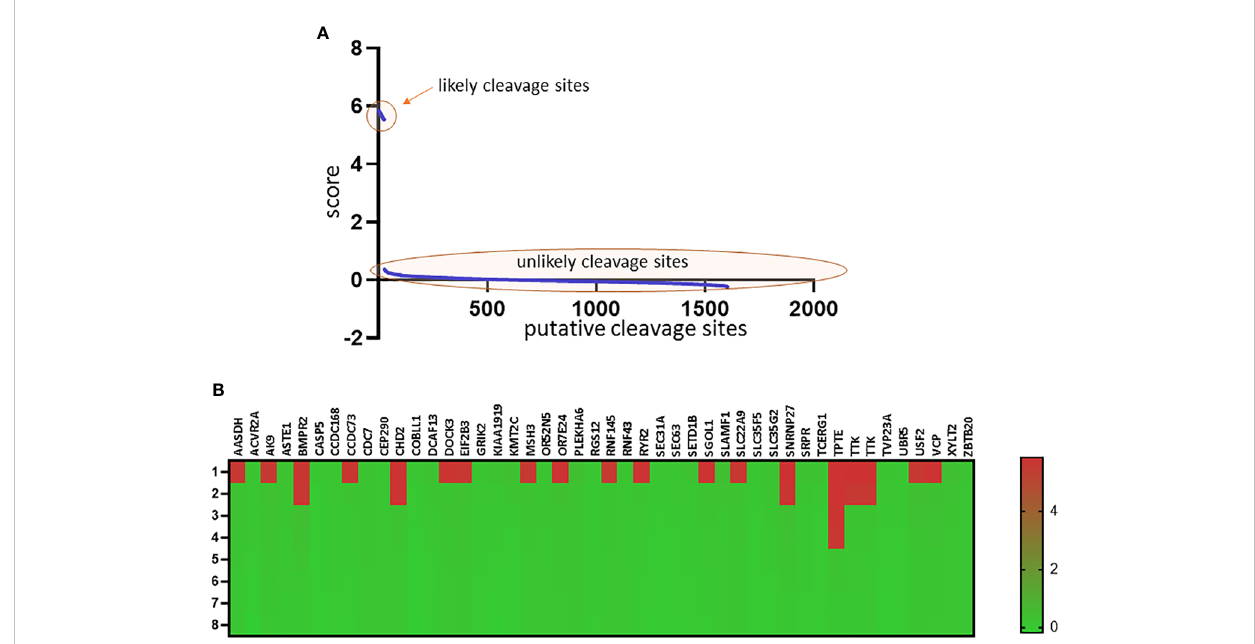
FIGURE 3 Predicted cleavage sites of Granzyme B in shared neoantigens in MSI-H tumors Representation of each predicted cleavage site score in decreasing order. Sites with the highest probability are located on the left side, sites with the lowest probability are located on the right side (Panel A ). Heatmap representing the top 8 cleavage sites of each shared neoantigen and their corresponding scores (Panel B ). On the top of the heatmap gene IDs from which each neoantigen originates are presented. Detailed results of each cleavage site prediction are presented in Supplementary Table